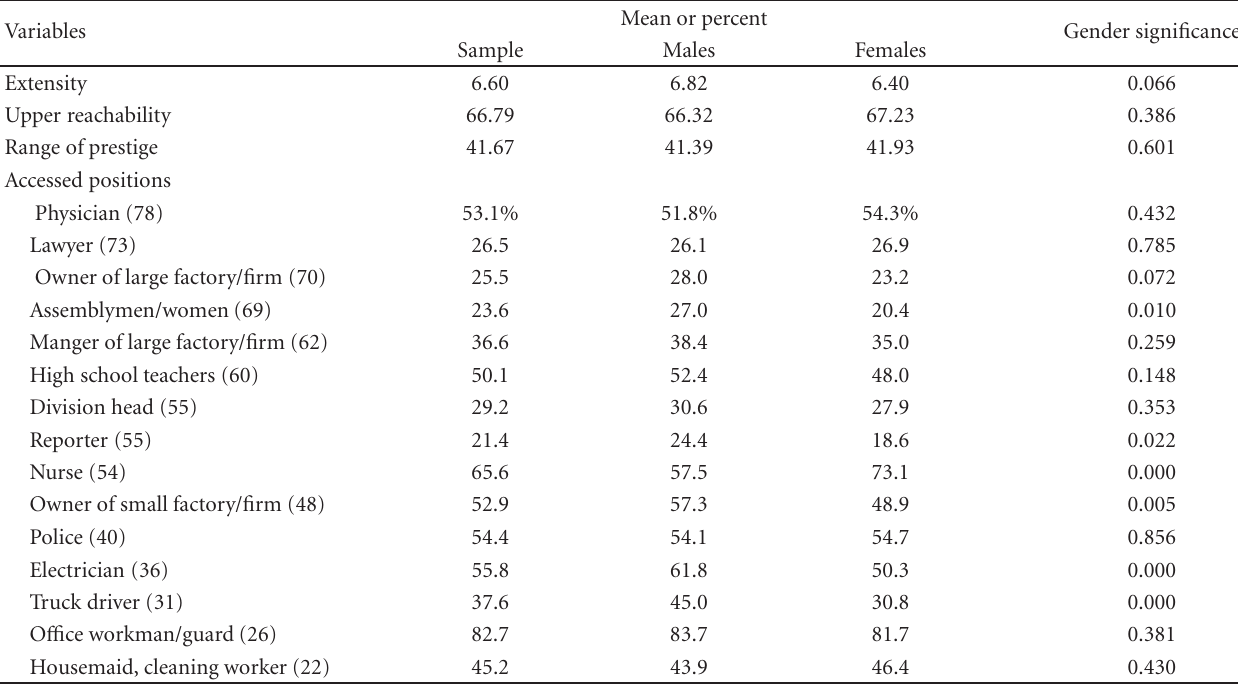
Table 1: Summary of position-generated variables.